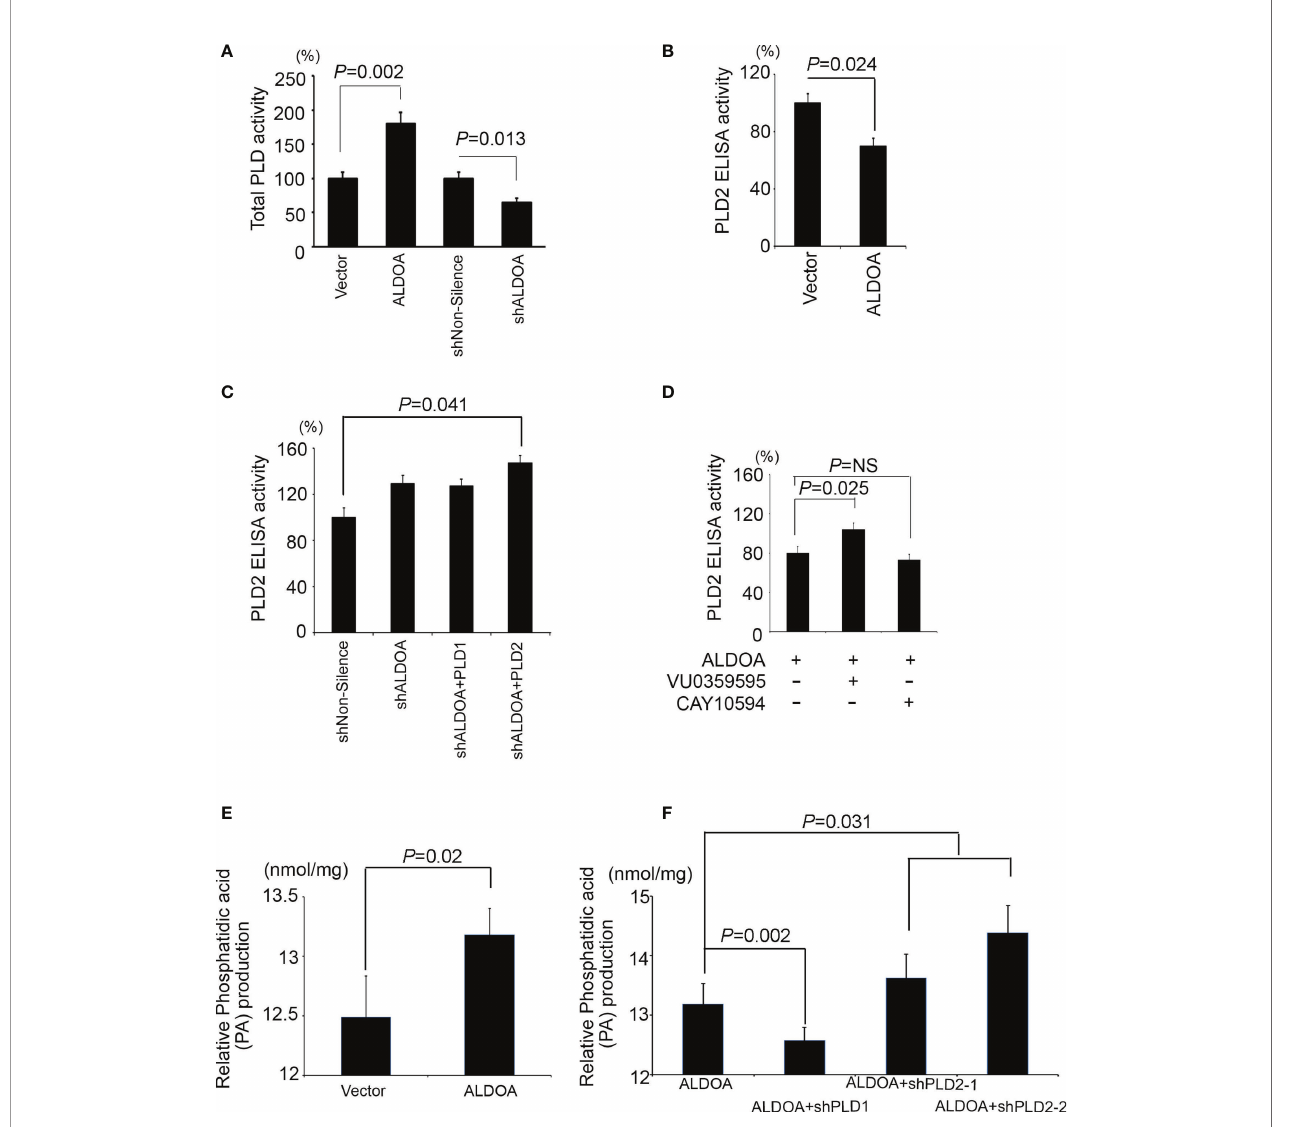
FIGURE 6 | ALDOA interferes with the activity of the PLD2 enzyme but increases the total PLD and phosphatidic acid products. (A) Intracellular PLD2 activity in CL1-0 cells with and without ALDOA gene overexpression. (B) Intracellular PLD2 activity in ALDOA knockdown CL1-5 cells with and without PLD1 or PLD2 overexpression. (C) Total intracellular PLD activity in an ALDOA two-way cell model. (D) Intercellular PLD2-speci fi c activity in ALDOA-overexpressing CL1-0 cells treated with pharmaceutical PLD1 inhibitor VU0359595 and PLD2 inhibitor CAY10594, respectively. In this study, 10 m M of VU0359595 and 50 m M of CAY10594. (E) Total intracellular phosphatidic acid production in the ALDOA overexpression model. (F) Total intracellular phosphatidic acid production in CL1-0 cells overexpressing ALDOA with and without PLD1 or PLD2 gene knockdown by shRNAs. The data from three independent experiments are presented in (A – F) as the means ± SEM. The signi fi cance of the difference was analyzed using the nonparametric Mann – Whitney U